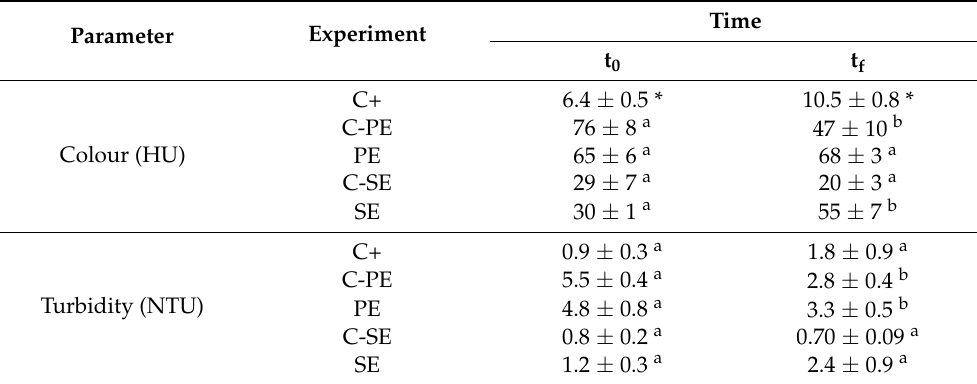
Table A1. Colour and turbidity measurements of the cell-free culture media at the beginning and end of each experiment.